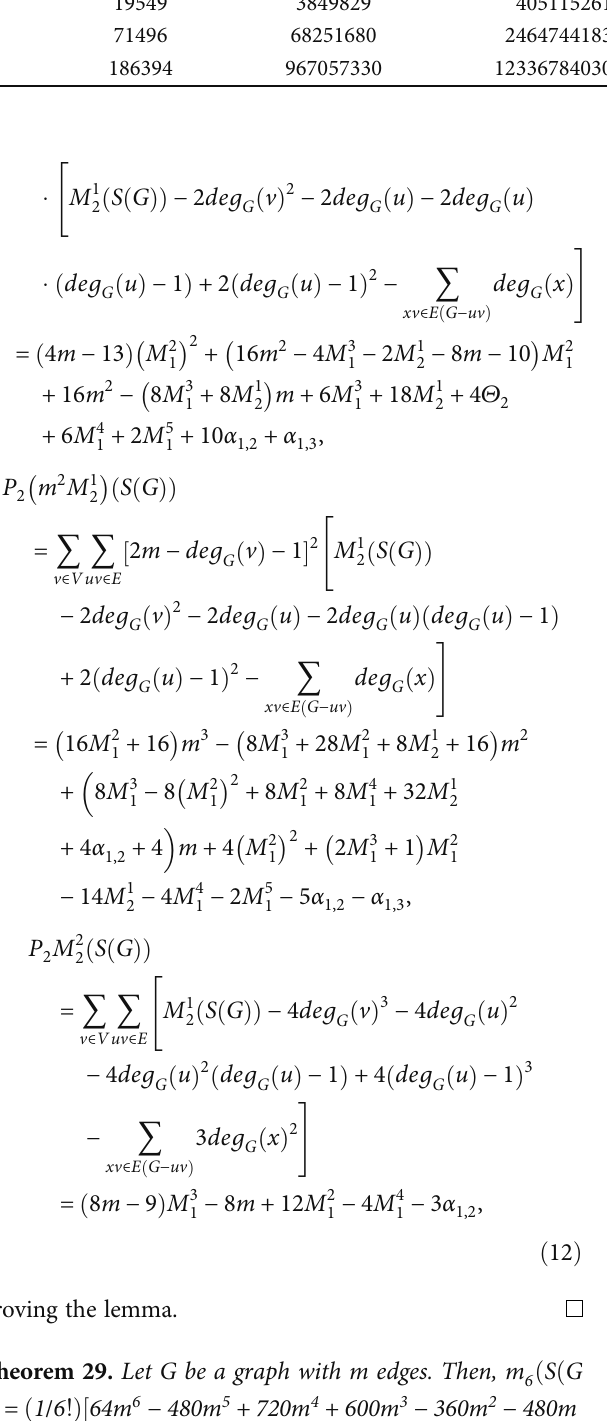
Table 2: The Laplacian coe ffi cients c